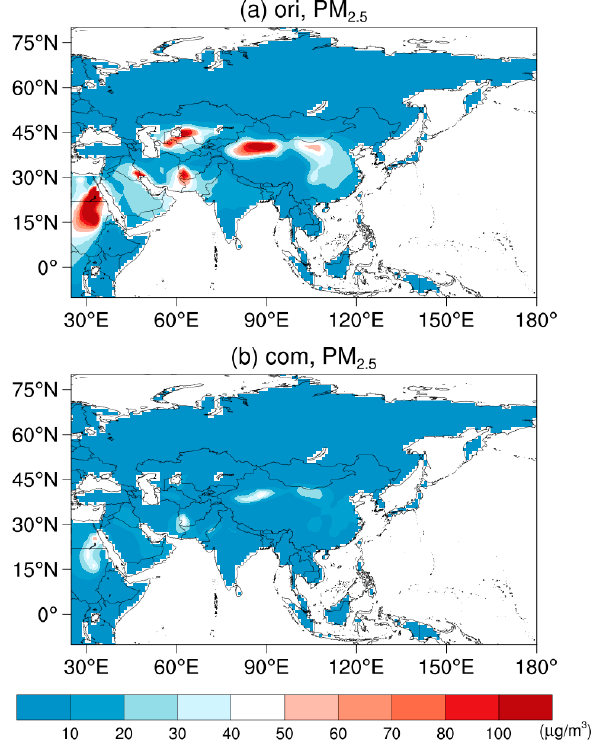
Figure 2. The standard deviation of simulated surface PM 2.5 concentrations (units: µg/m 3 ) among models during 1998–2014 from ( a ) the original simulations and ( b ) the estimations. To evaluate the performance of CMIP6 models in simulating monthly surface PM 2.5 concentrations in different regions of Asia, the annual cycles of the original and estimated surface PM 2.5 in sub-regions of Asia based on MERRA-2 are compared in Figure 3. Surface PM 2.5 concentrations peak in spring and summer over WAS, in spring and autumn over EAS, and in summer and autumn over SAS. Both ori-MME and com-MME capture the annual cycle of surface PM 2.5 concentrations over Asia well, but with underestimates over CAS and WAS and overestimates over other sub-regions. The monthly differences simulated by CMIP6 GCMs are small over NAS and SEAS. The estimated annual cycles of surface PM 2.5 concentrations over NAS, SAS, SEAS, and EAS are close to that in MERRA-2 but underestimated over WAS. Due to the sparsely covered distributed ground-based observation, we cannot investigate the source of the bias of CMIP6 models.